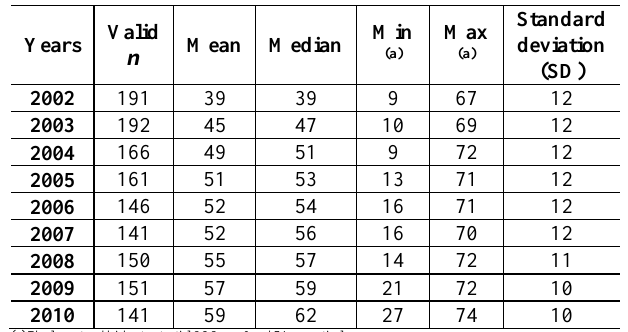
Table 4: Corporate governance scores